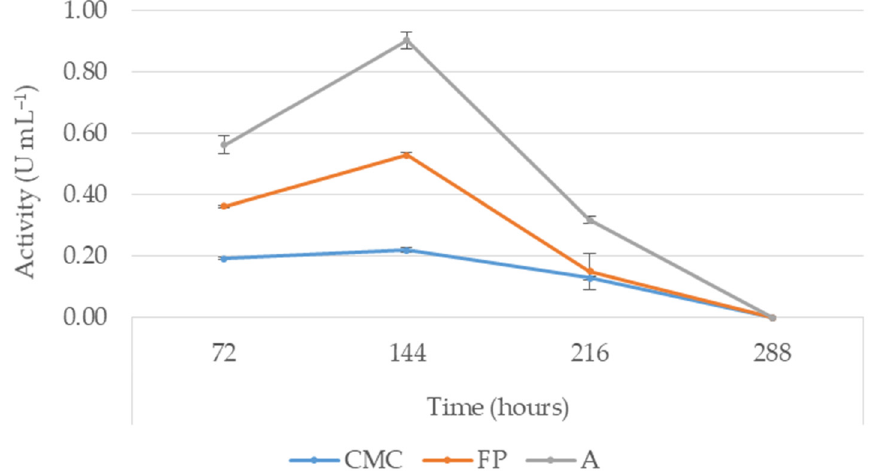
Figure 2. Avicelase production of Bacillus sp. 8E1A with various sources of cellulose.